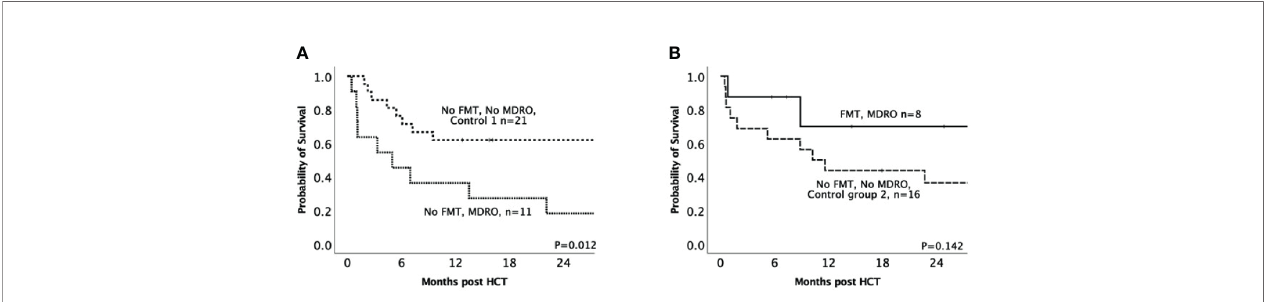
FIGURE 3 | Impact of MDRO colonization on clinical outcomes for patients receiving HCT – matched MDRO vs non-MDRO groups. (A) Kaplan-Meier curve of overall survival in patients colonized with multidrug-resistant organisms who did not receive FMT ( ‘ no FMT MDRO ’ , dotted line; n = 11) in comparison to controls who were not colonized and were matched for disease type, disease stage, transplant intensity, donor type (matched sibling, matched unrelated, and haploidentical), and age ( ‘ no FMT no MDRO control 1 ’ , dashed line; n = 21); (B) Kaplan-Meier curve of overall survival in patients colonized with multidrug-resistant organisms who underwent fecal microbiota transplantation ( ‘ FMT MDRO, solid line; n = 8) comparison to controls who were not colonized and were matched for disease type, disease stage, transplant intensity, donor type (matched sibling, matched unrelated, and haploidentical), and age ( ‘ no FMT no MDRO control 2 ’ , dash-dotted line n =